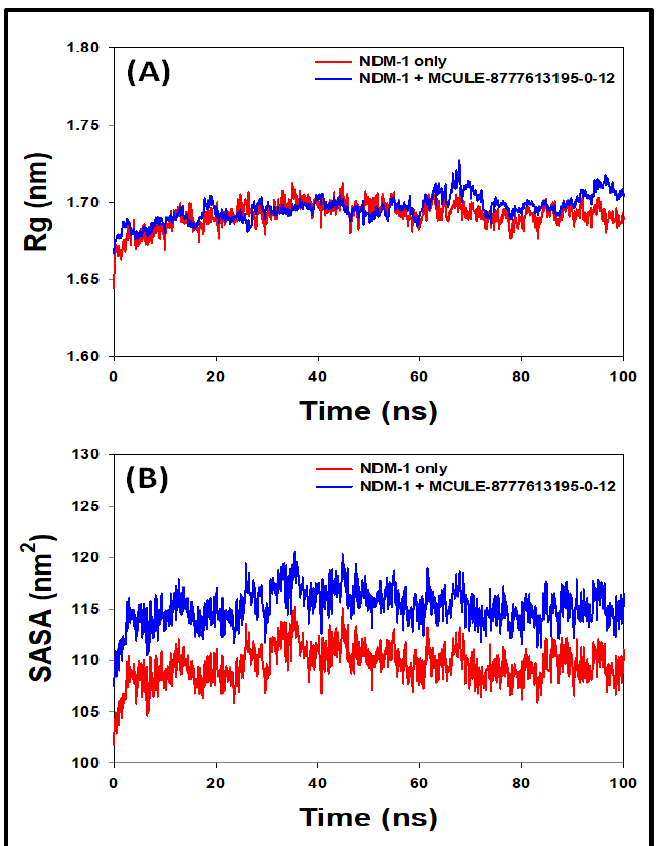
Figure 4. Variation in the ( A ) radius of gyration (rGyr); ( B ) solvent accessible surface area (SASA) of NDM-1 in the presence of